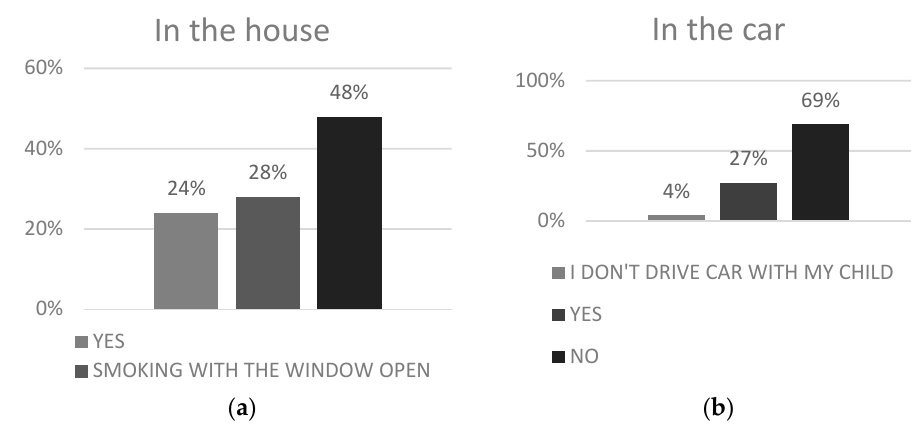
Figure 2. No smoking policy in child’s environment: ( a ) in the house; ( b ) in the car.